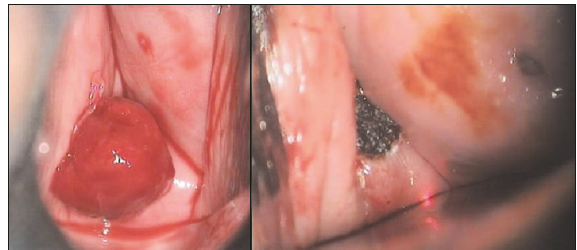
Figure 1: Vaginal polyp before and immediately after excision with electrocoagulation of the polyp base (both photos have been obtained and shared with the patient’s informed consent).